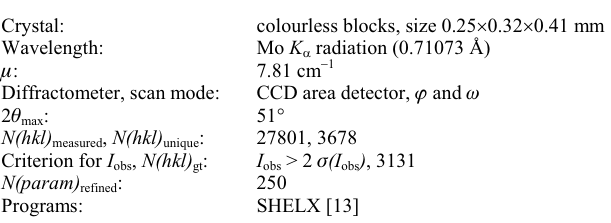
Table 1. Data collection and handling.